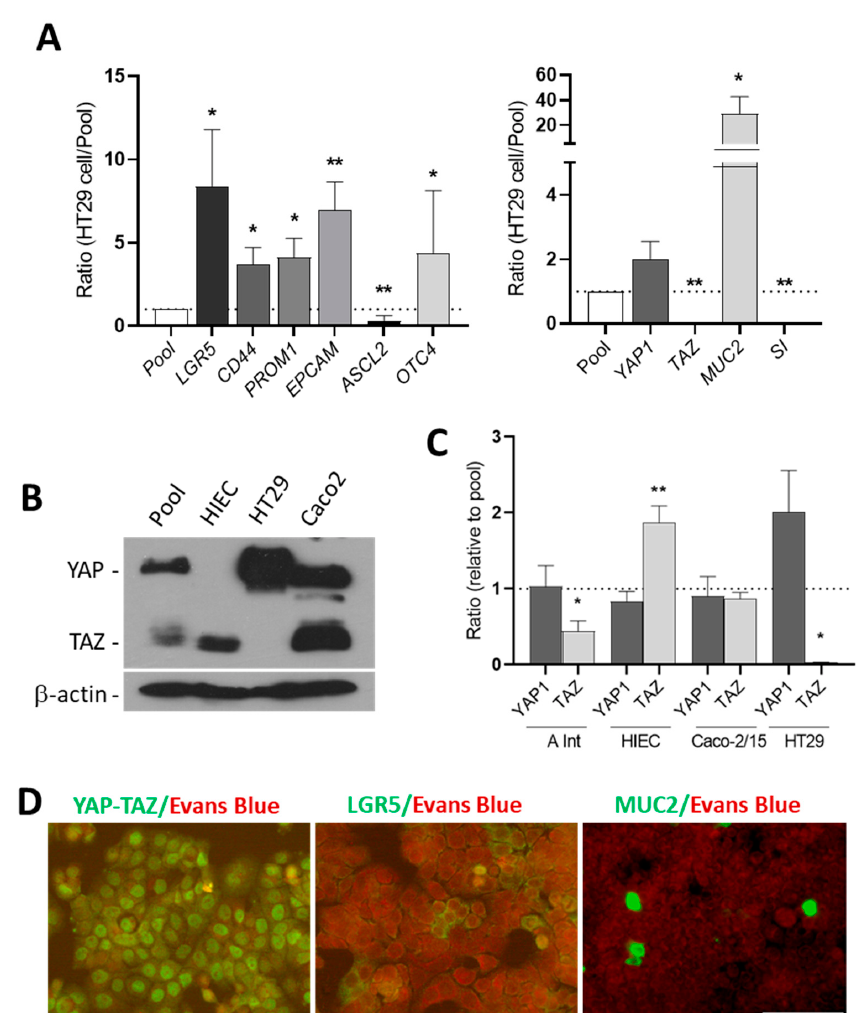
Figure 2. Expression of stem cell markers, Hippo effectors, goblet and absorptive cells markers in HT29 cells. ( A ) Expression of LGR5 , CD44 , PROM1 , EPCAM , YAP1 , TAZ , MUC2 and SI transcripts in HT29 cells relative to a pool of cancer cells. * p < 0.05, ** p < 0.01. ( B ) Western blot analysis showing